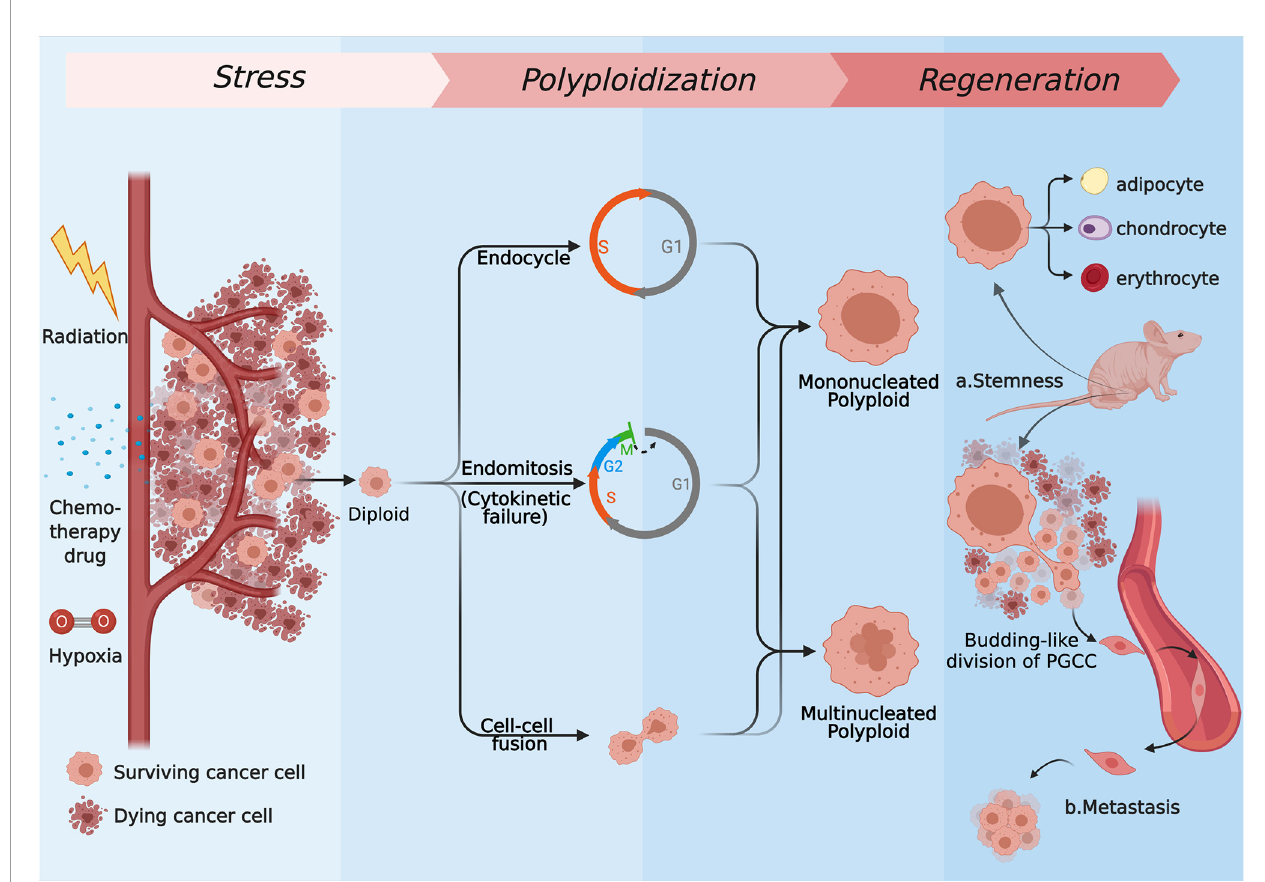
FIGURE 1 | The several strategies of polyploidization under stress and the regeneration process of PGCCs. Most of the tumor cells are killed by radiation, chemotherapy drugs, hypoxia drugs, or other kinds of stress, while the rest of cells express resistance to those kinds of stress. Some of surviving cells form mononucleated or multinucleated cells through endoreplication (endocycle, endomitosis, or cytokinetic failure) or cell – cell fusion. Repopulating via neosis and differentiating to normal tissues like cells, PGCCs can show stemness in vivo (A) , and they are capable of generating distant metastases through the EMT (B) . (Created with